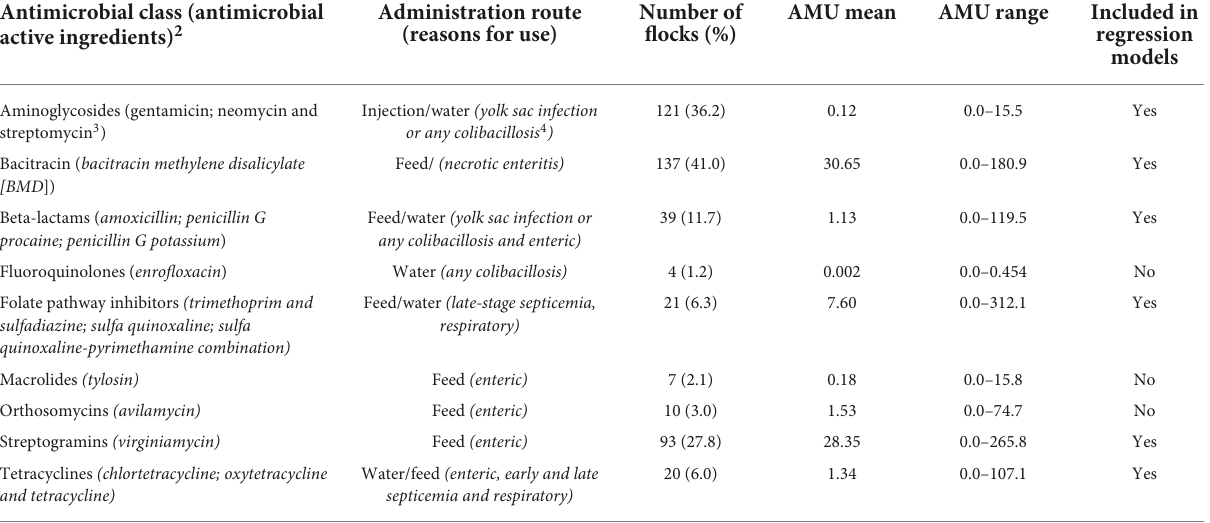
TABLE 1 Quantity, administration route, and disease indication of antimicrobial use (AMU) 1 in Canadian turkey flocks ( n = 334) between 2016 and 2019. Antimicrobial class (antimicrobial active ingredients)